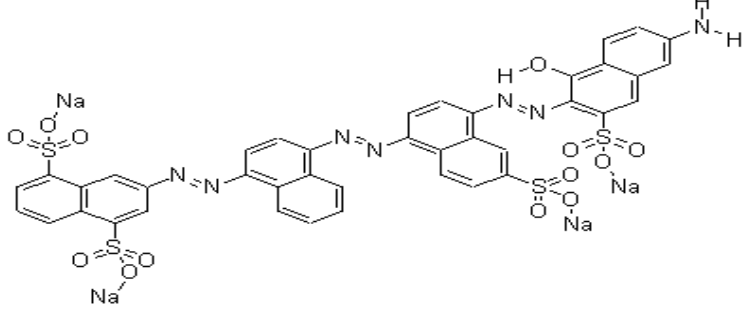
Figure 1. Molecular structure of Direct Blue